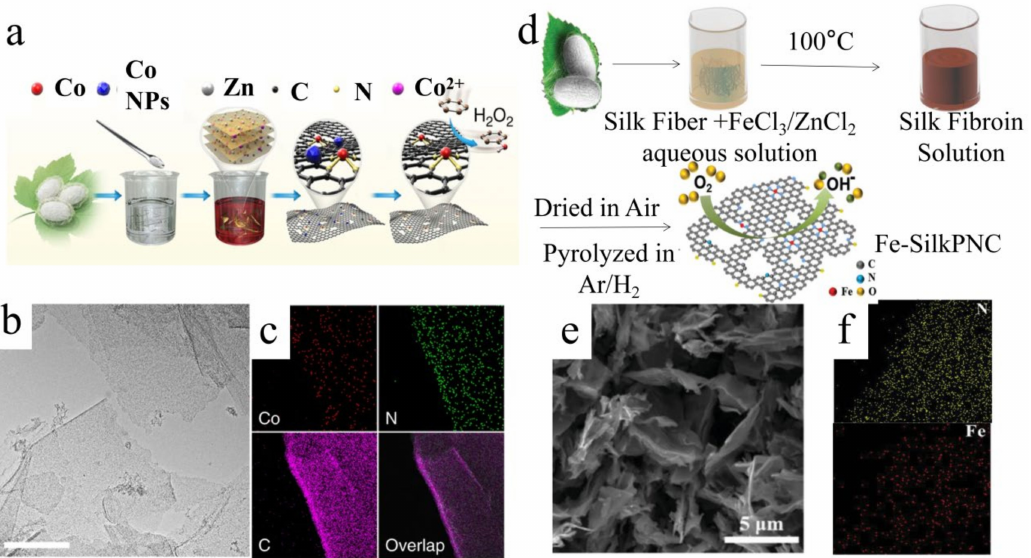
Figure 9. ( a ) Preparation process of a Co-ISA/CNS catalyst [161], ( b ) TEM image of Co − ISA/CNS, ( c ) EDX elemental mapping of CoISA/CNS. Reprinted from Ref [161] Copyright (2018) with permis- sion from Springer Nature. ( d ) The reparation process of Fe-SilkPNC, ( e ) TEM image of Fe-SilkPNC, ( f ) EDX elemental mapping of Fe-N x -C. Reprinted from Ref. [153] Copyright (2019) with permission from